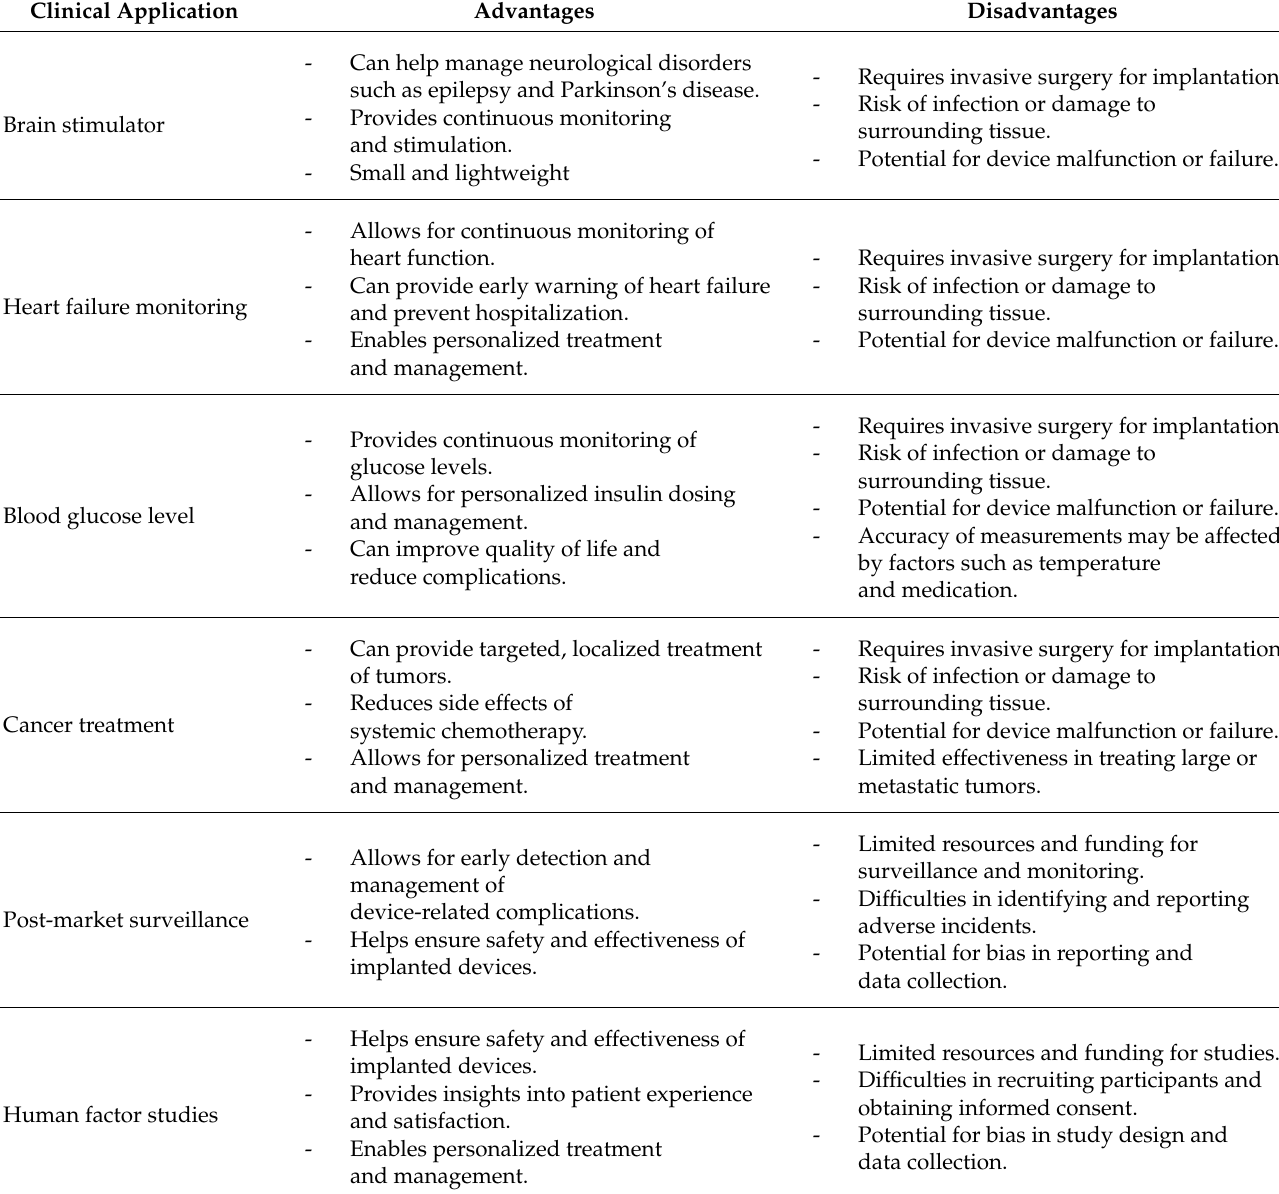
Table 1. Advantages and disadvantages of clinical applications of implantable biosensors and evaluation of their post market surveillance and human factor studies